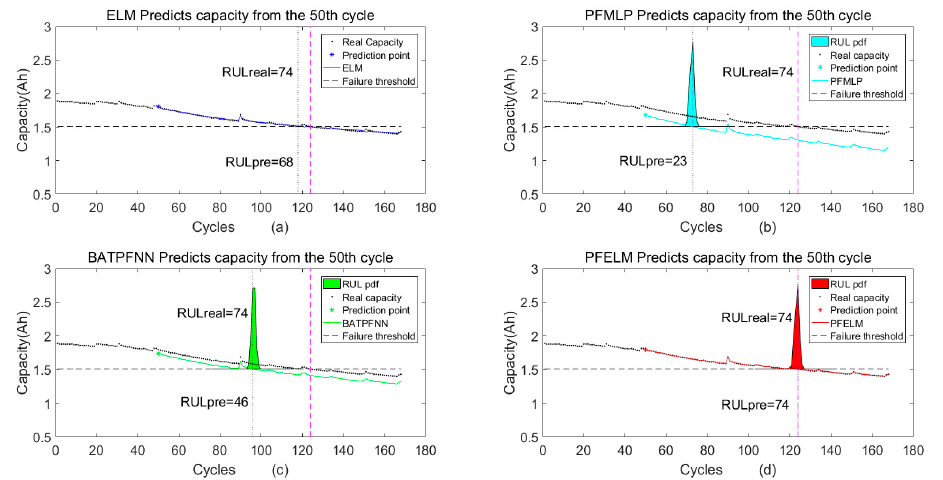
Figure 17. Capacity prediction error from the first cycle.